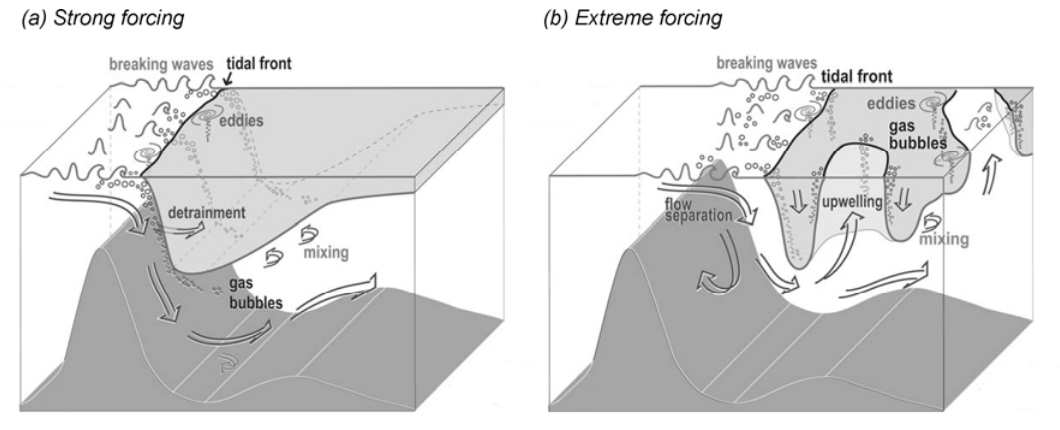
Figure 2. Sketch of processes active near the sill during strong ( a ) and extreme ( b ) flood tidal forcing. View is from the east (From Baschek et al.